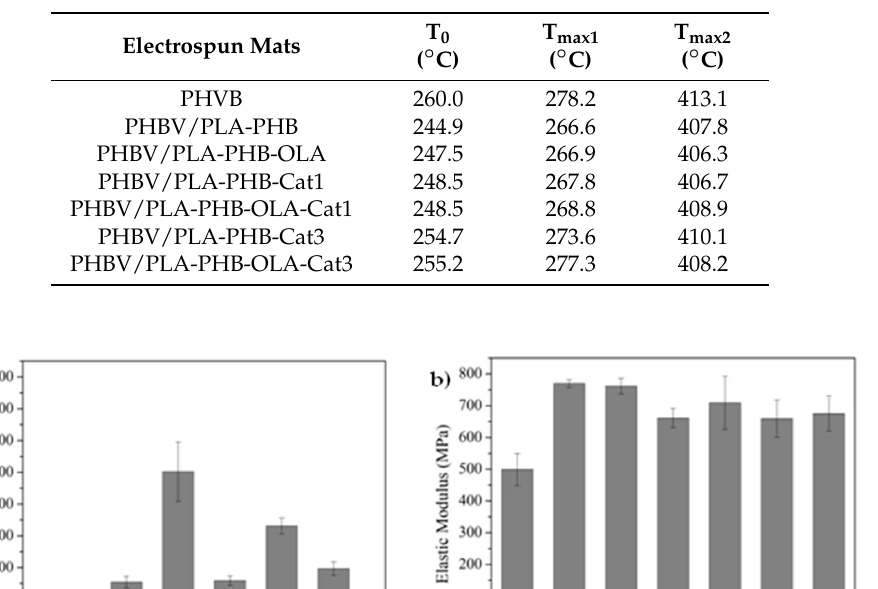
Table 3. TGA and DTG results of bilayer systems.